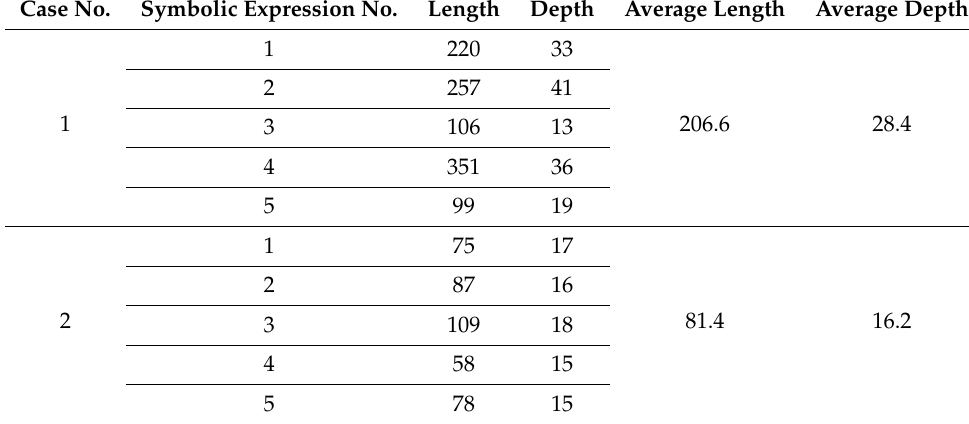
Table 6. The symbolic expressions length and depth of each case with average length and depth. Case